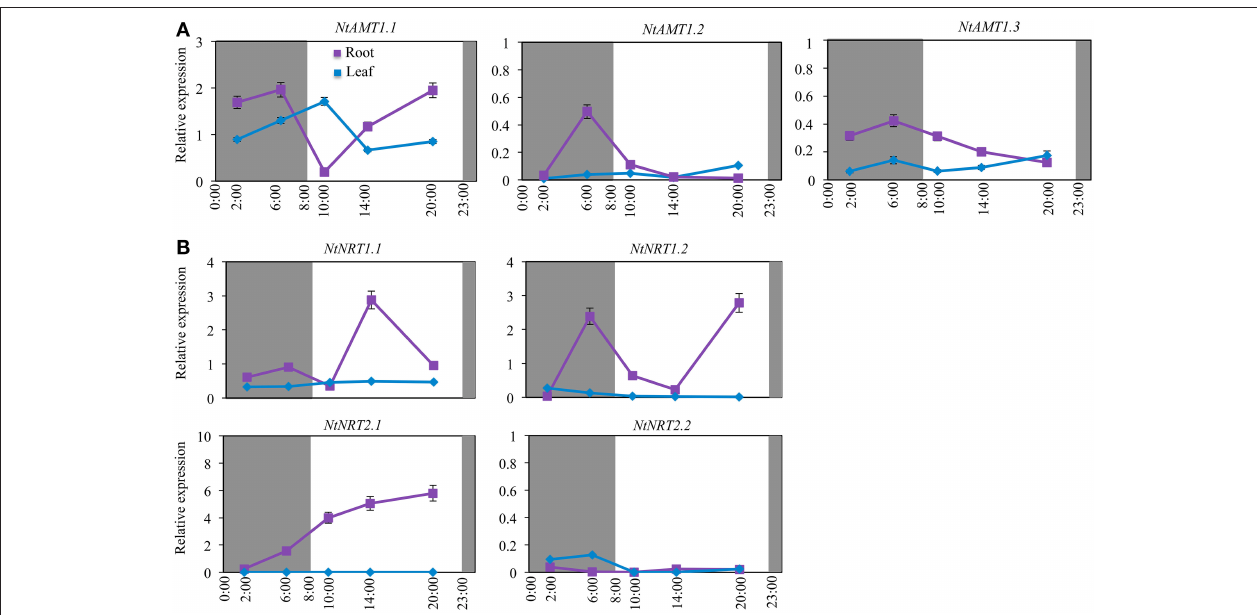
FIGURE 4 | Diurnal-dependent expression of AMTs (A) and NRTs (B) in roots and leaves of tobacco k326. Plants were hydroponically cultured in a growth chamber with a 15h light/9h dark circle (08:00–23:00/23:00–8:00) (see section Materials and Methods). Plant samples were harvested at 2:00, 6:00, 10:00, 14:00, and 20:00. Relative mRNA accumulation of NtAMTs and NtNRTs was quantified by qPCR, which was conducted with total RNA from roots and leaves (1 d after fully-opened) of plants grown on normal nutrition solution for 3-week (see section Materials and Methods). Expression levels of NtAMTs and NtNRTs are relative to that of α -tubulin gene (set to 1). Mean values of 3–4 biological samples ± SD ( n = 3–4) were shown. L25 was used as a second reference gene to affirm the expression pattern observed from that using tubulin as an internal control (Figures S2E,F). Purple or blue lines indicate respectively root and leaf. The relative expression of those NtAMT s with a low level and less diurnal-variation pattern is shown in Figure S4.